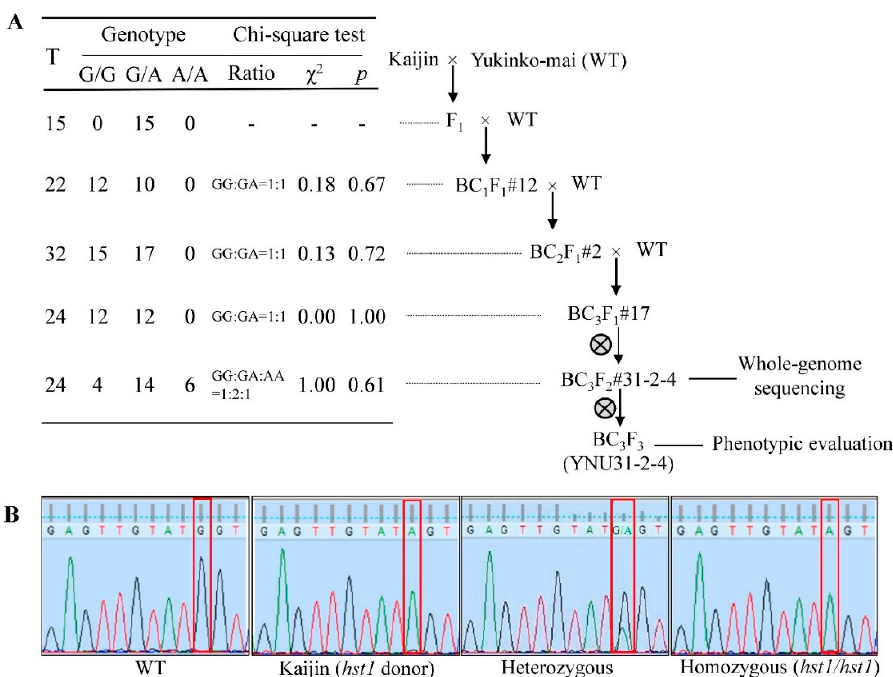
Figure 1. Single nucleotide polymorphism (SNP) marker-aided introgression of hst1 from “Kaijin” into “Yukinko-mai”. ( A ) The hst1 gene was transferred from highly salt-tolerant “Kaijin” into “Yukinko-mai”. “Kaijin” was backcrossed to “Yukinko-mai” (WT) 3 times followed by 2 rounds of self-pollination. The table shows the selection results at each generation: T, total number of tested plants; G / G, number of plants not carrying donor allele; G / A, number of plants carrying donor allele in heterozygous state; A / A, plants carrying donor allele in homozygous state. The number after “#” is the individual plant number used in backcrossing or self-pollination. ( B ) Advanced breeding individuals were genotyped by direct sequencing. The red box represents nucleotide 1975 of the OsRR22 locus, which is responsible for salt tolerance.